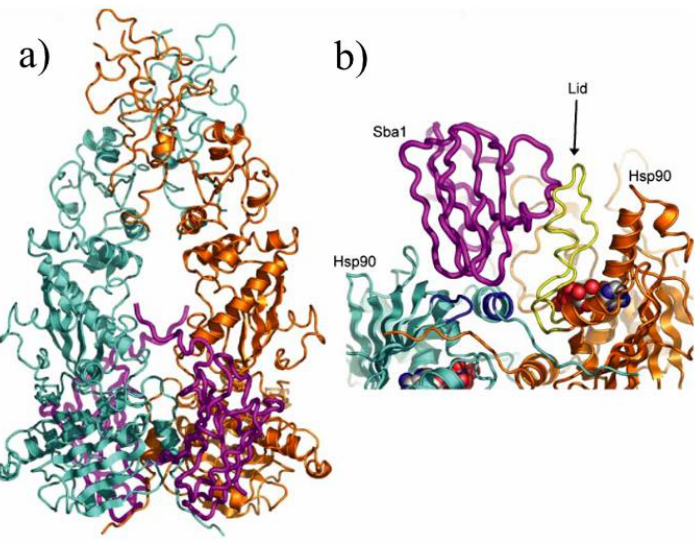
Figure 4. ( a ) Crystal structure of HSP90 in complex with p23/Sba1. Dimers of HSP90 are individually colored teal and orange, and p23/Sba1 is depicted in violet [65]. ( b ) Closeup image of p23/Sba1 interacting with the ATP-bound, closed-lid conformation of HSP90 [65].